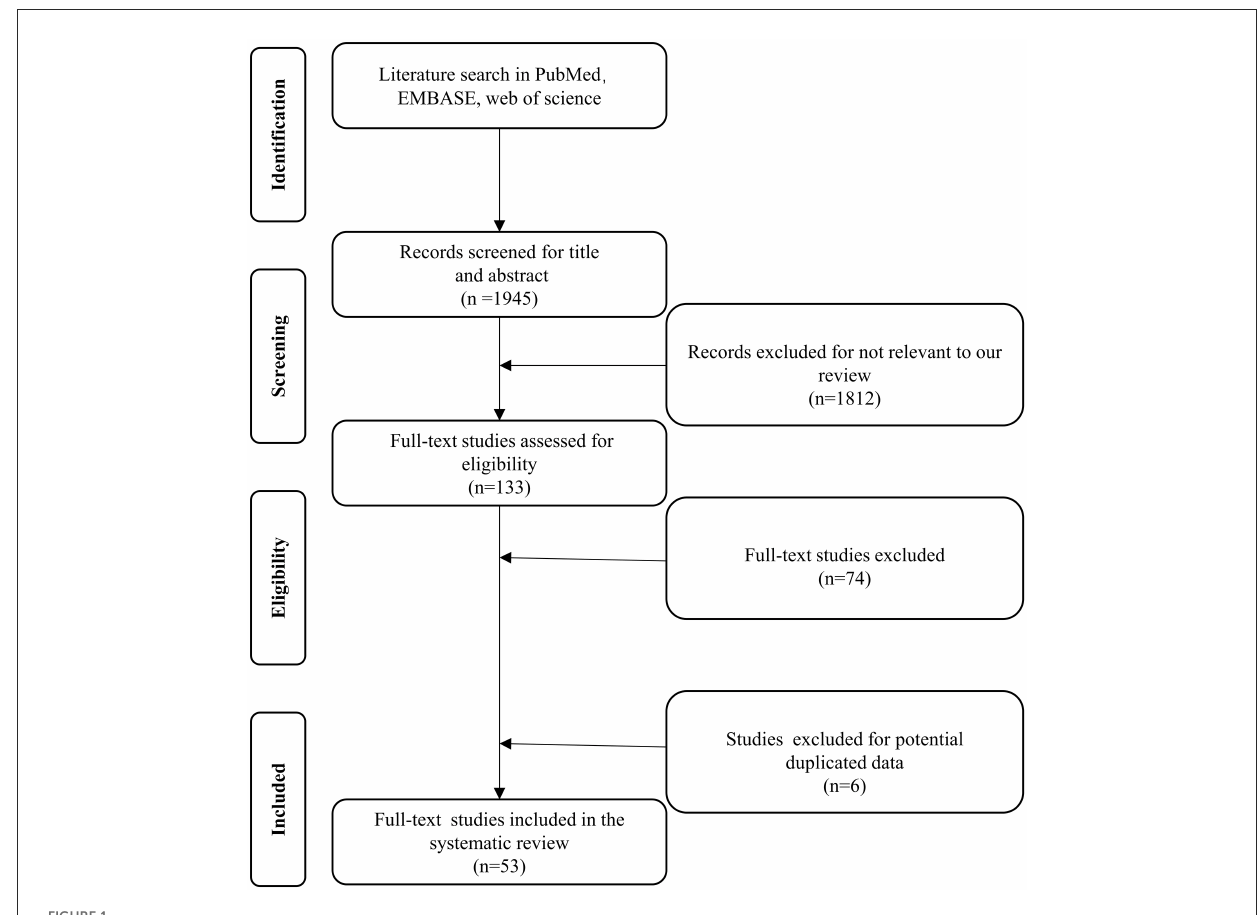
FIGURE1 Preferred reporting items for systematic reviews and meta-analysis flow